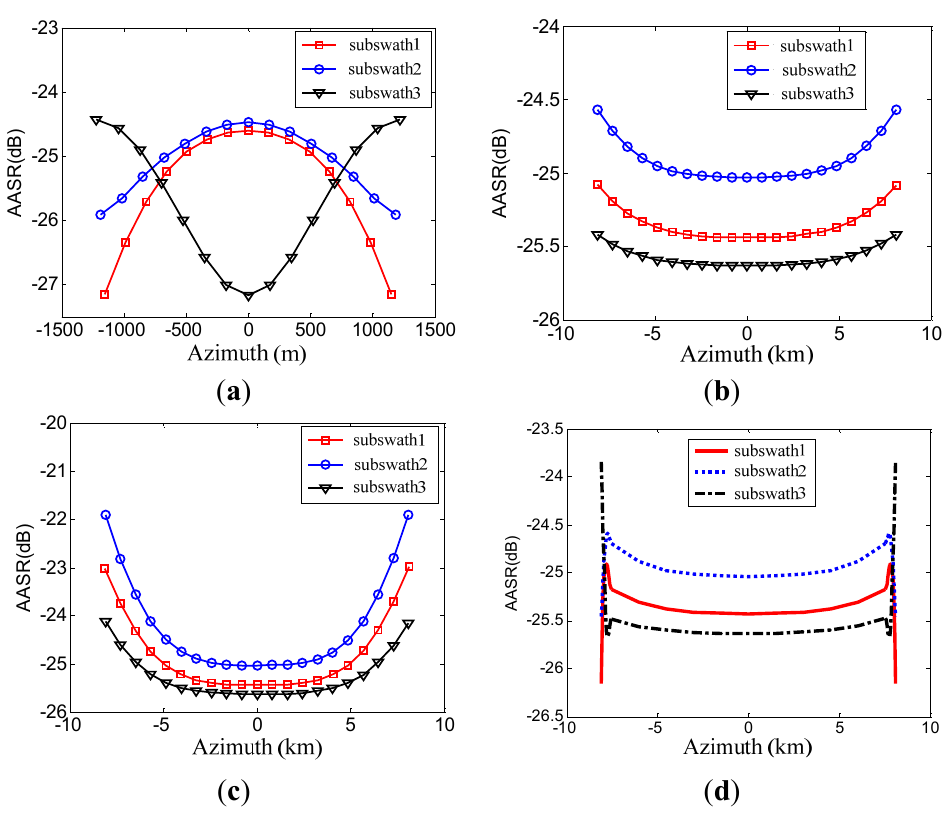
Figure 10. AASR of different imaging modes. ( a ) ScanSAR; ( b ) TOPS; ( c ) ITOPS; ( d )